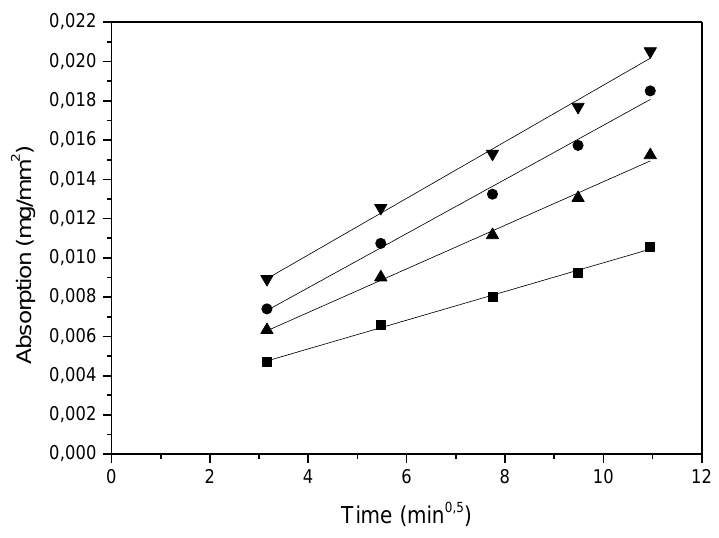
Figure 7 . Capillary absorption vs time at different FBA contents: ■ 0%; ▲ 10%; ● 20%; ▼ 30%.